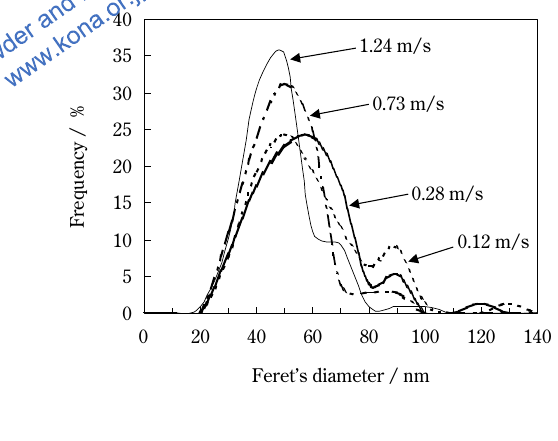
Fig. 6 Effect of mixing condition on particle size distribution of BaTiO 3 particles by sol-gel method.